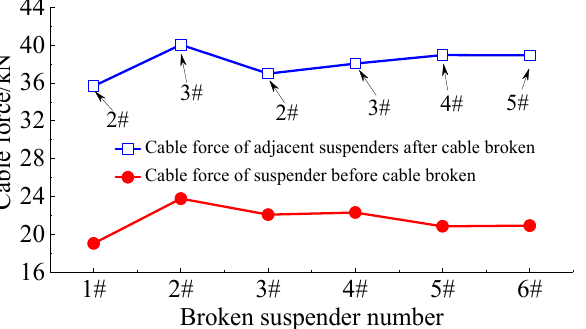
Figure 16. Maximum value of the hanger force response when different suspenders fracture .